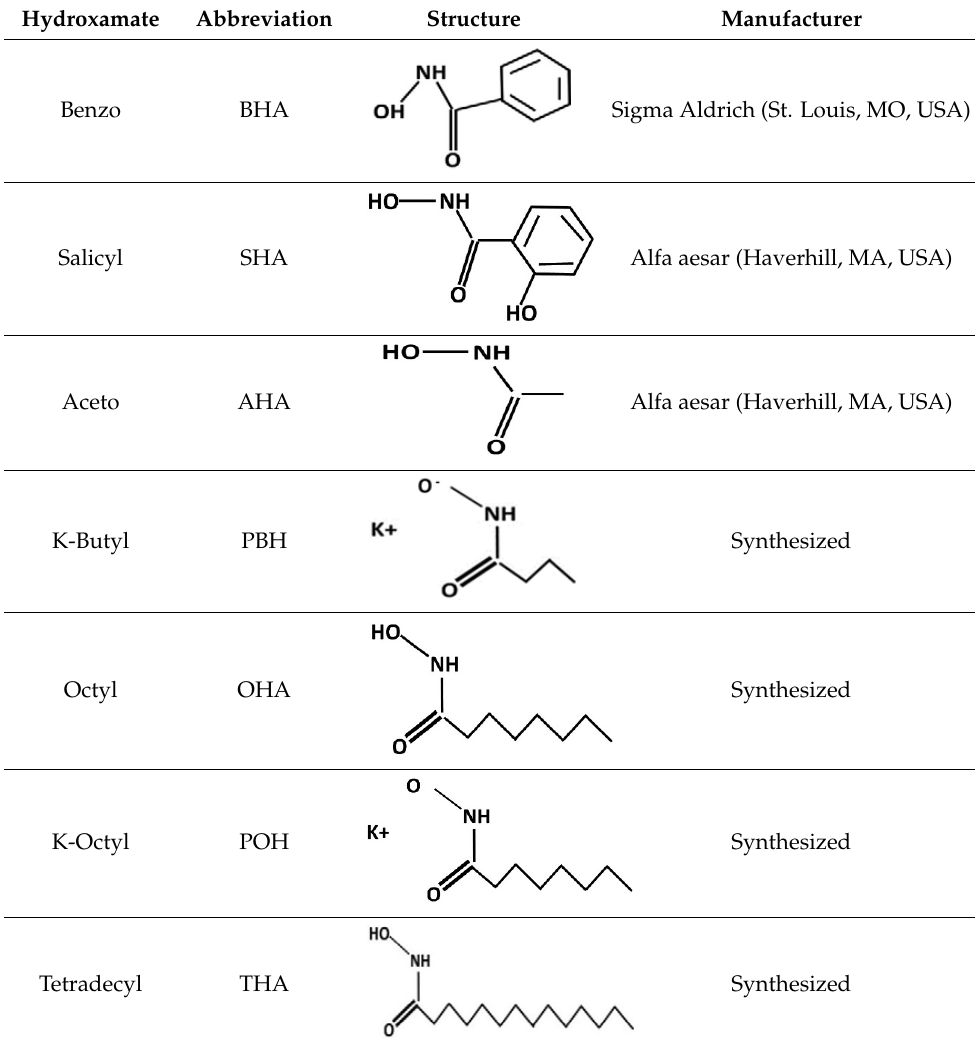
Table 7. Hydroxamate collectors used in malachite flotation [89].